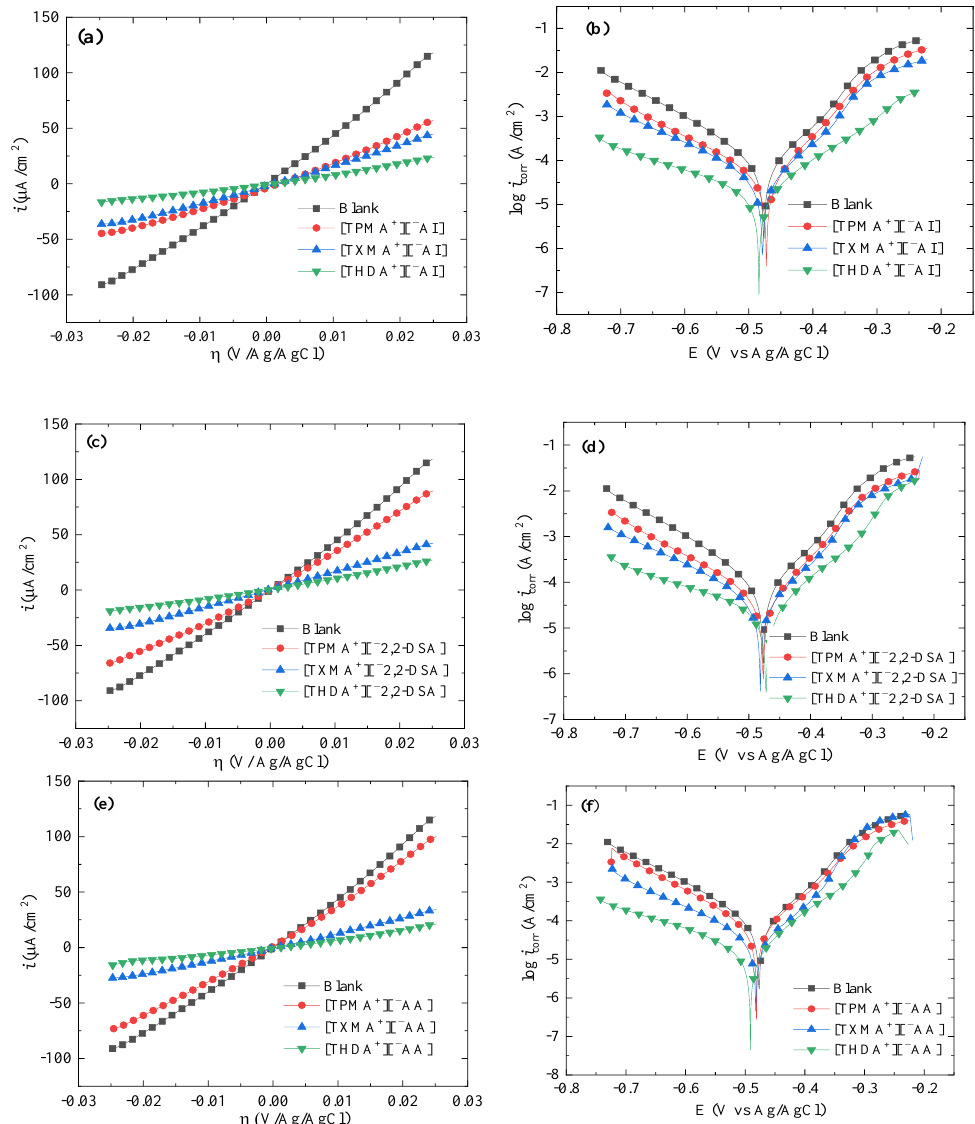
Figure 2. Rp and Tafel polarization of API X52 steel in 0.5 M HCl at 100 ppm of ILs with cations [TPMA + ], [TXMA + ], and [THDA + ] and anions: ( a , b ) [ − AI], ( c , d ) [ − 2,2-DSA], and ( e , f ) [ − AA]. Table 2 presents the electrochemical parameters calculated by linear regression of Rp and linear extrapolation of the Tafel polarization curves of API X52 steel in 0.5 M HCl at 100 ppm of ILs: Rp , corrosion potential ( E corr ), anodic and cathodic Tafel slopes ( β a and β c ), and i corr . The inhibition efficiency by Rp ( IE Rp ) and Tafel curves ( IE Tafel ) of the ILs are also reported in Table 2, which were calculated with Equations (1) and (2), respectively: